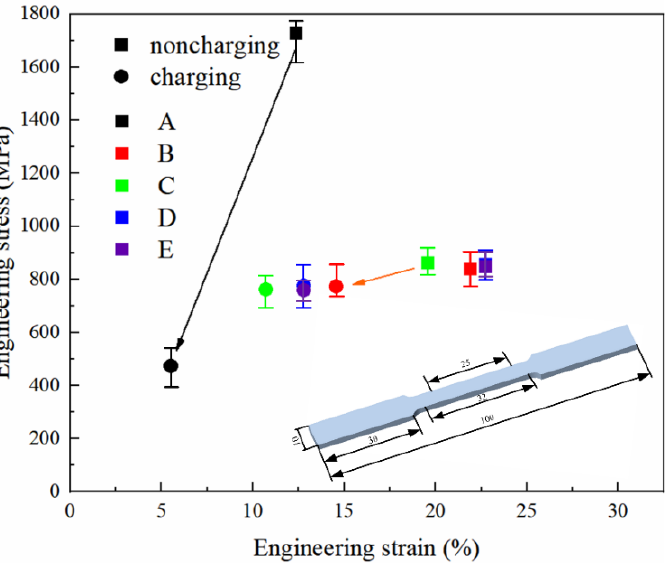
Figure 8. Comparison of the changes in strength and ductility of each group of materials before and after electrolytic hydrogen charging.